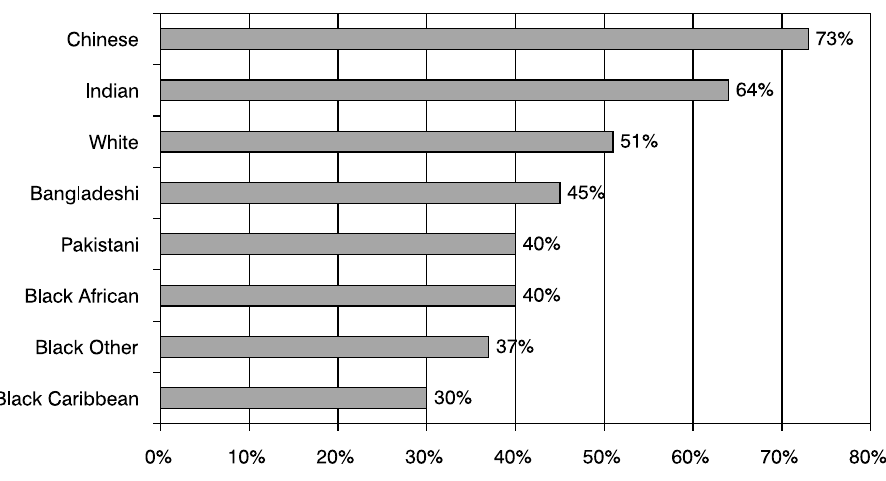
Figure 5. GCSE performance by ethnic groups in England (5+A*-C) Source : DfES (2003) Aiming High: raising the achievement of ethnic minorities pupils, March (PLASC 2002